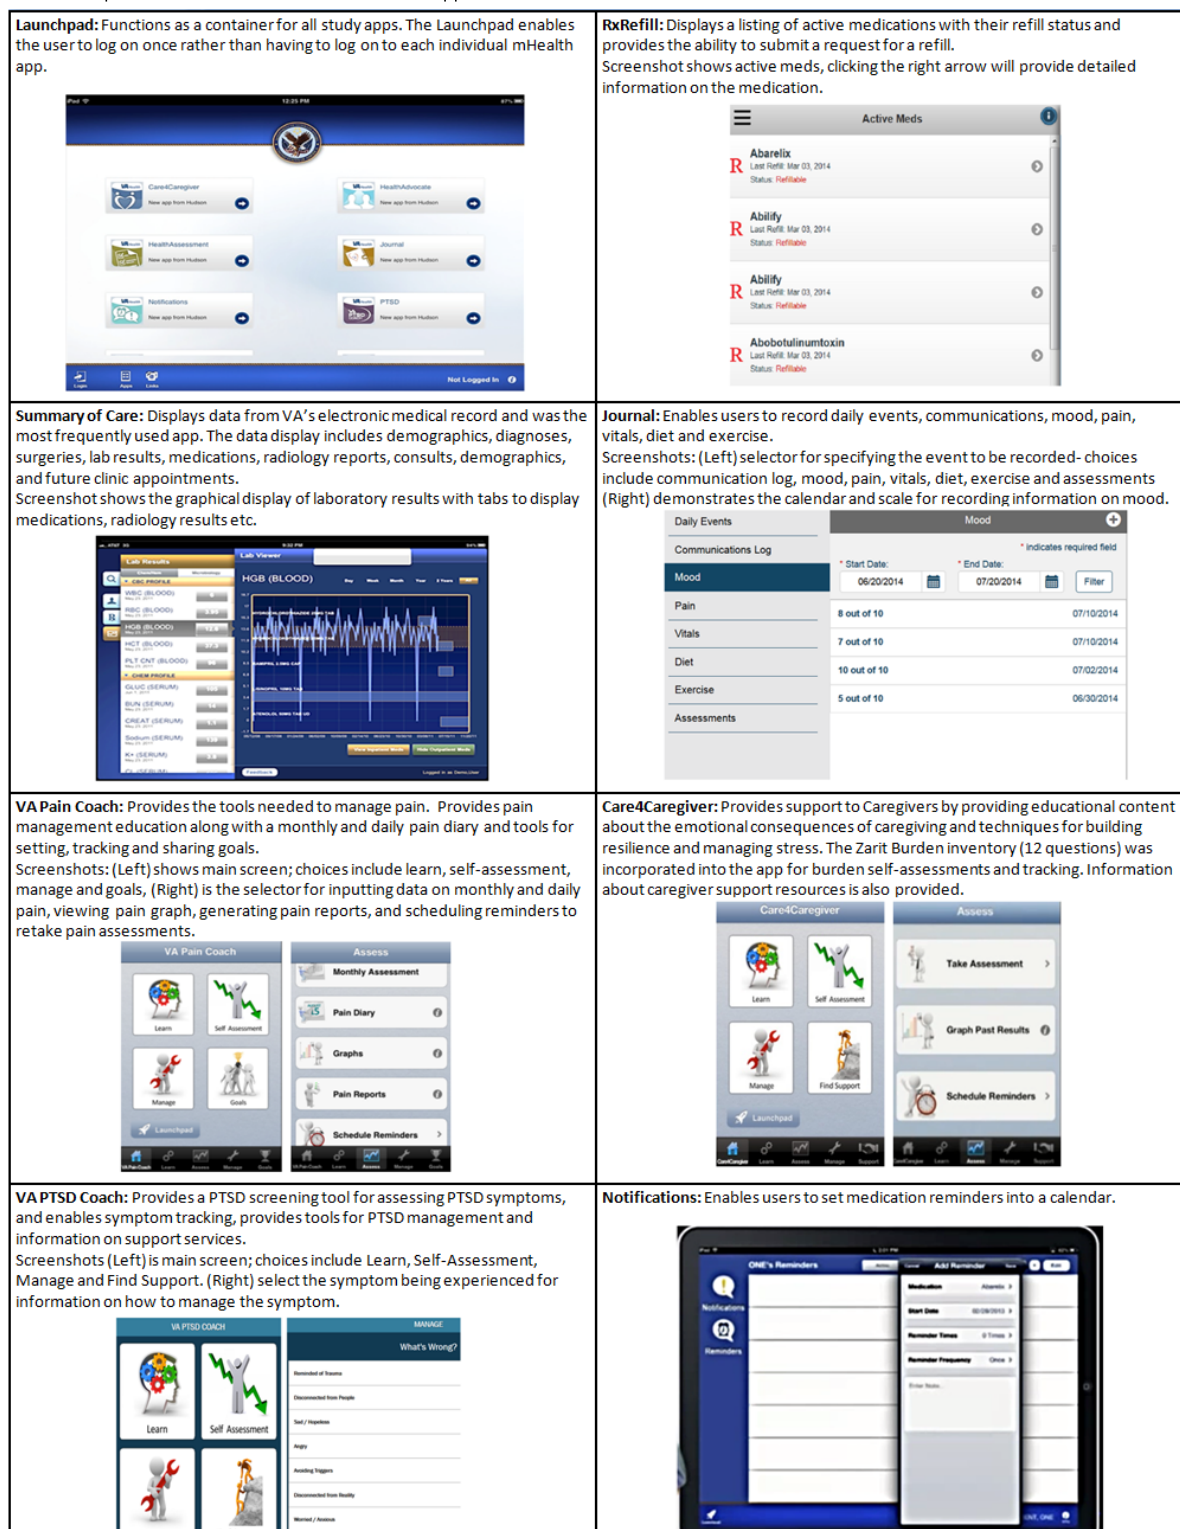
Figure 2. Descriptions and screenshots of the mHealth